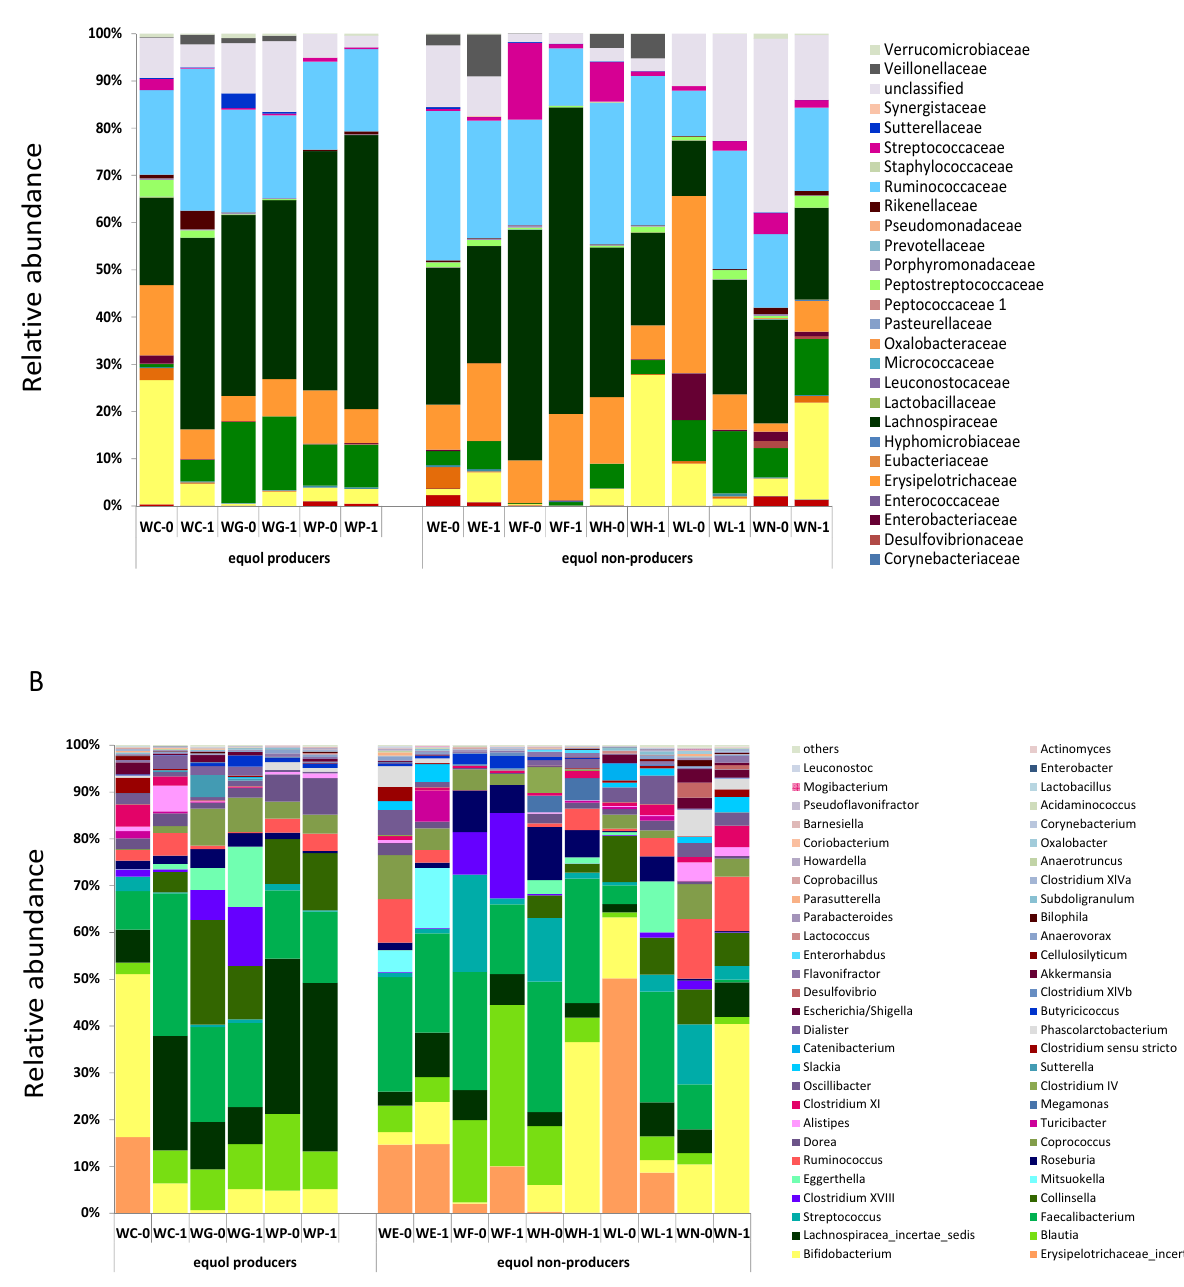
Figure 1. Changes in microbial composition with isoflavone supplementation. Microbial composition at the family ( A ) and genus ( B ) levels in fecal samples of eight menopausal women before (T0) and after one month (T1) of isoflavone supplementation presented as relative abundances (%).